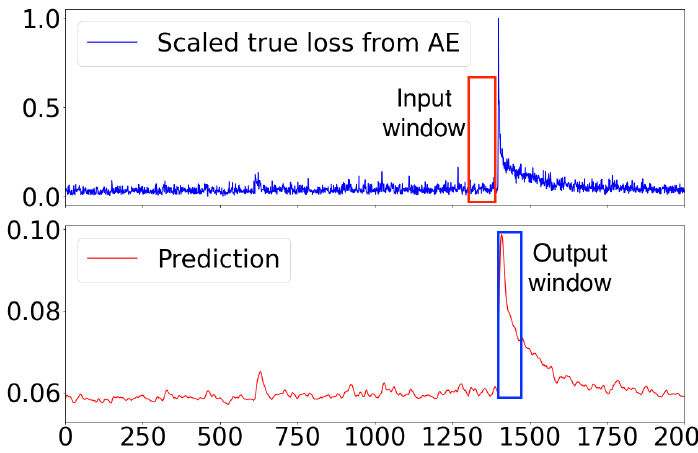
Figure 20. An empirical study with the autoencoder (AE)–temporal convolutional network (TCN) joint